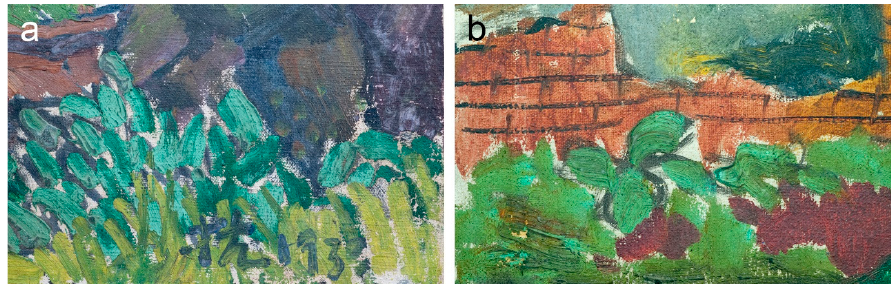
Figure 16. Details showing the intentionally exposed colour of the ground and thin application of colours in the painting process in: ( a ) Countryside landscape , 1933; ( b ) Courtyard, Shanghai , 1933.